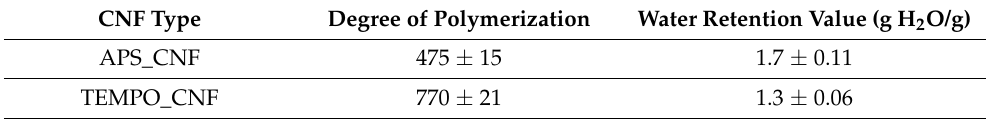
Table 5. Some characteristics of APS_CNF and TEMPO_CNF (adapted from